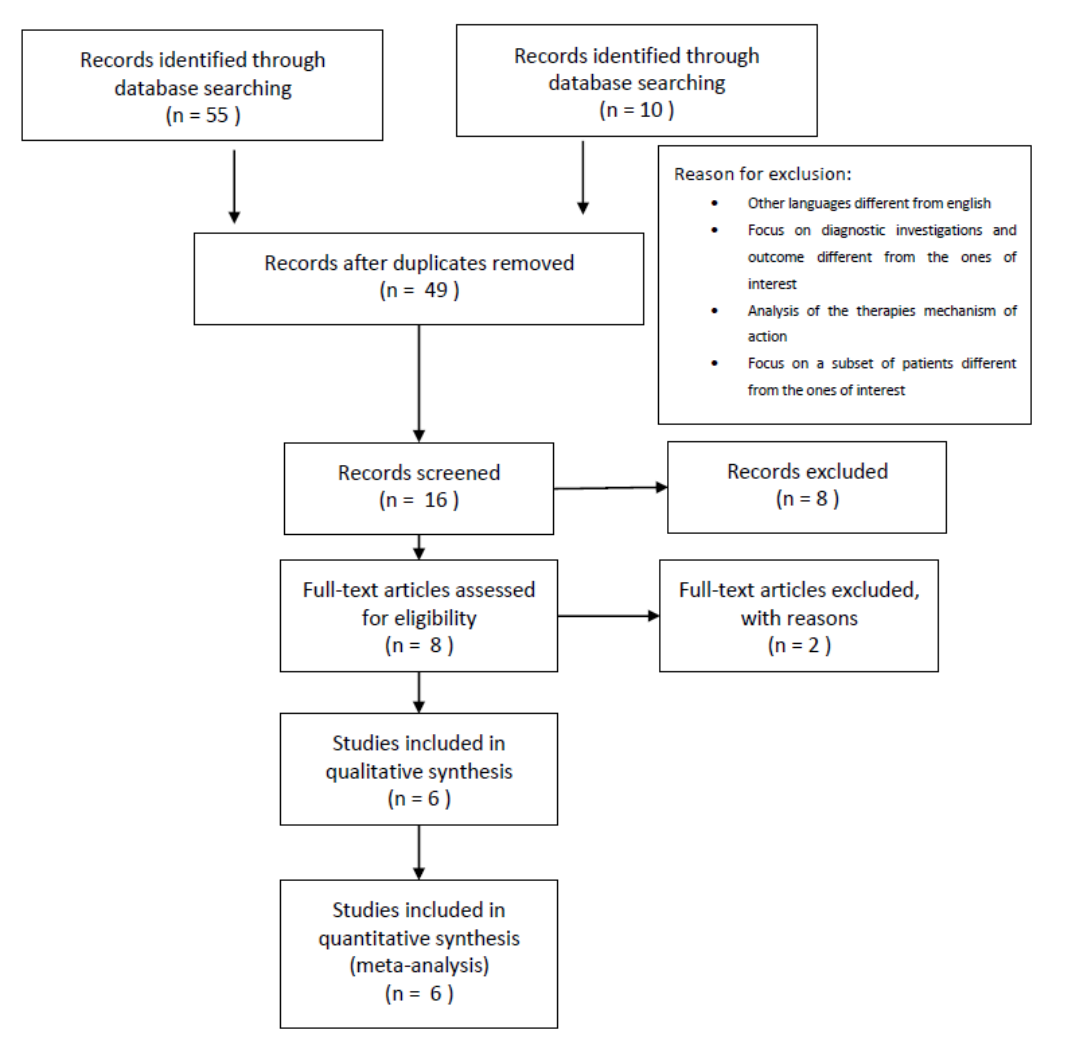
Figure 1. Prisma flowchart.